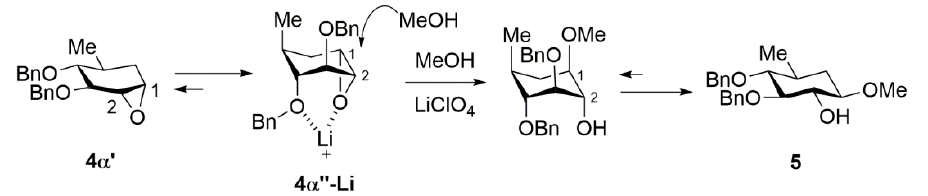
Figure 1. Conformational equilibrium shift due to the lithium coordination.